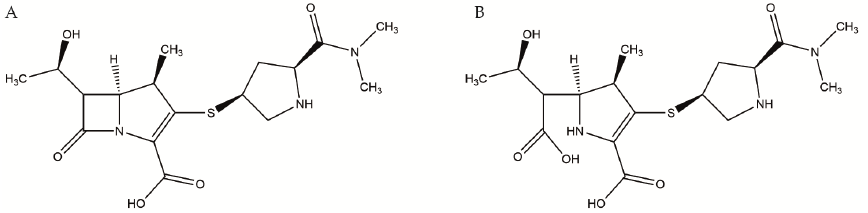
Figure 6. Molecular structure of meropenem ( A ) and its main degradation product, the open-ring metabolite (ORM) ( B ).